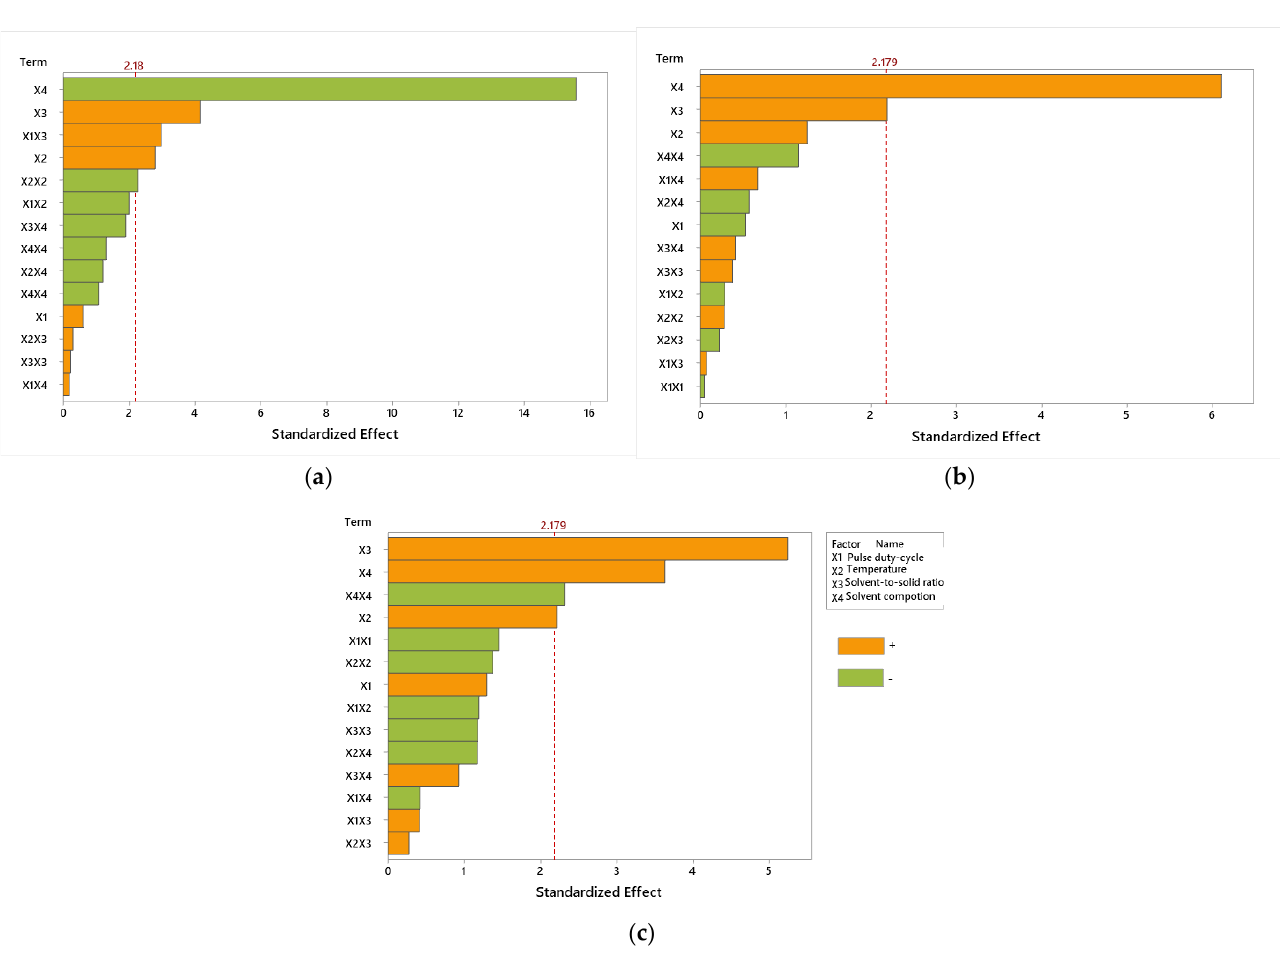
Figure 1. Pareto chart for the standardized effect of the UAE variables on the level of ( a ) benzoic derivatives, ( b ) cinnamic acid derivatives, and ( c ) flavonoids. derivatives, ( b ) cinnamic acid derivatives, and ( c )